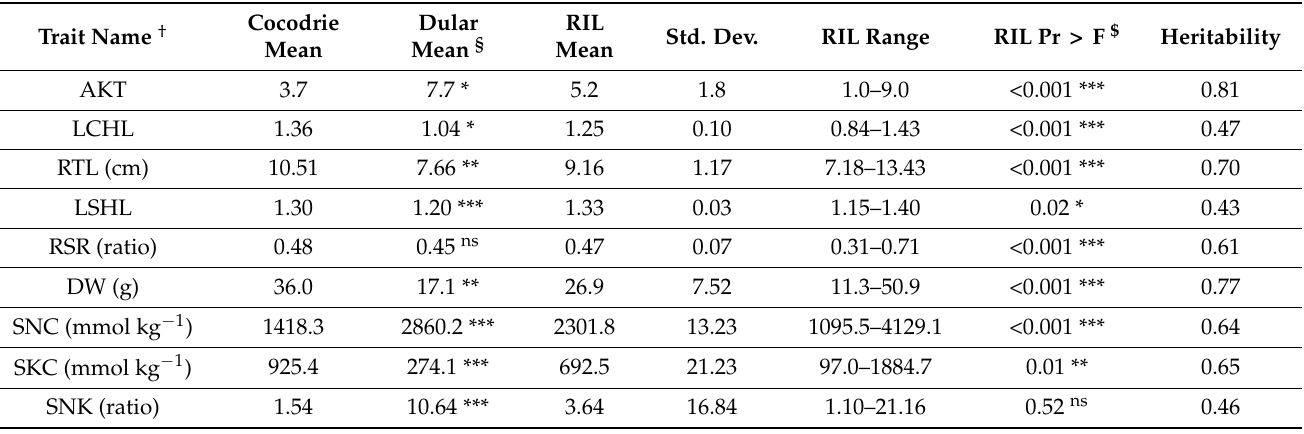
Table 1. Means for various morphological and physiological traits in parents and Cocodrie × Dular RIL population under alkaline stress at the seedling stage.